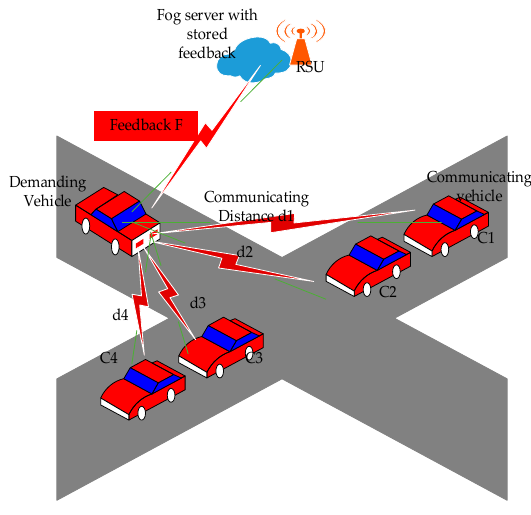
Figure 6 . Node communication with a fog server. Figure 6. Node communication with a fog